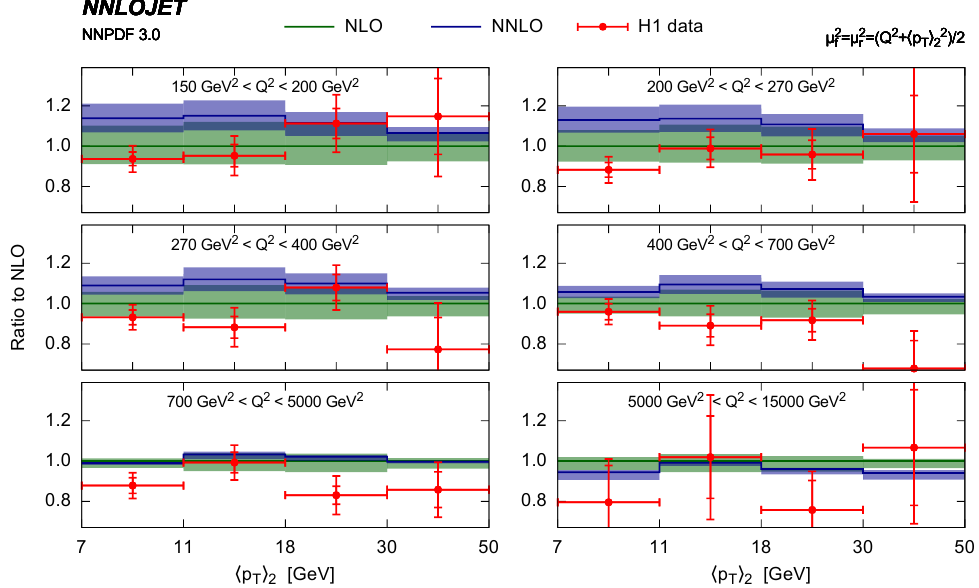
Figure 14 . Inclusive di-jet production cross section as a function of p B to H1 high- Q 2